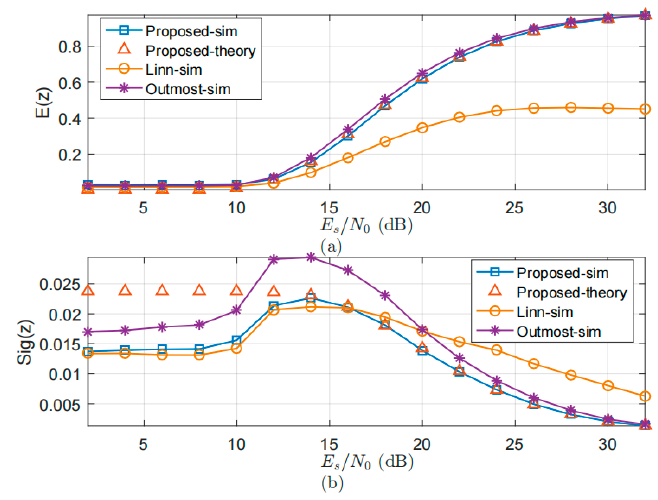
Figure 6. Expectation and variance versus SNR under the condition that carrier synchronization is locked for the 32APSK signal: ( a ) expectation; ( b ) variance.